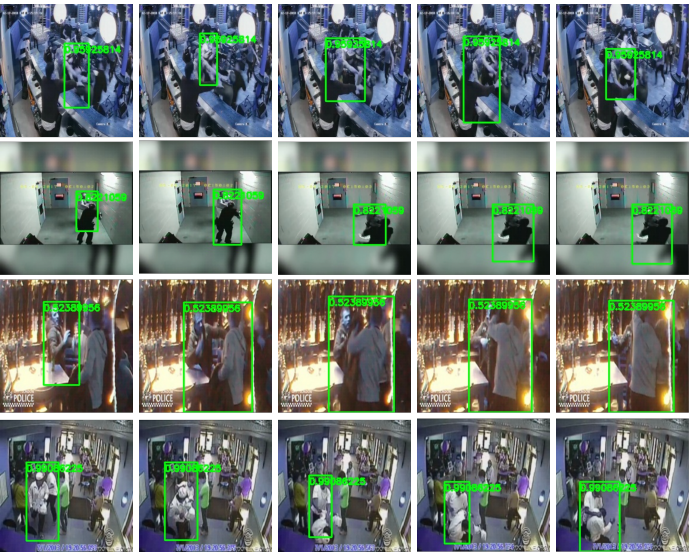
Figure 11. Sample violence localizations for some surveillance videos where each row represents a different video. Green bounding boxes enclose the actors of the violent action, and they are labeled with the violence score predicted by the proposed